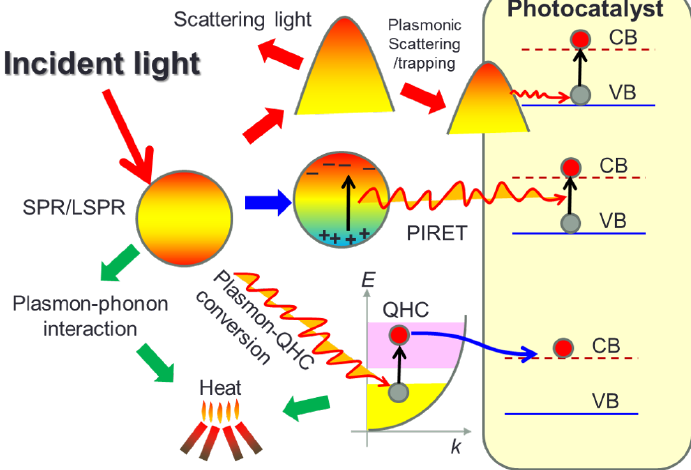
Figure 1. Various types of energy transformation in plasmonic photocatalytic reactions. Figure redrawn from reference